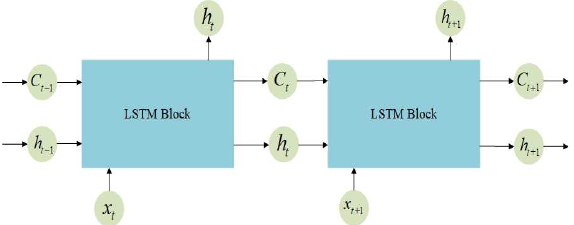
Figure 1. The un-rolled LSTM sequential architecture.